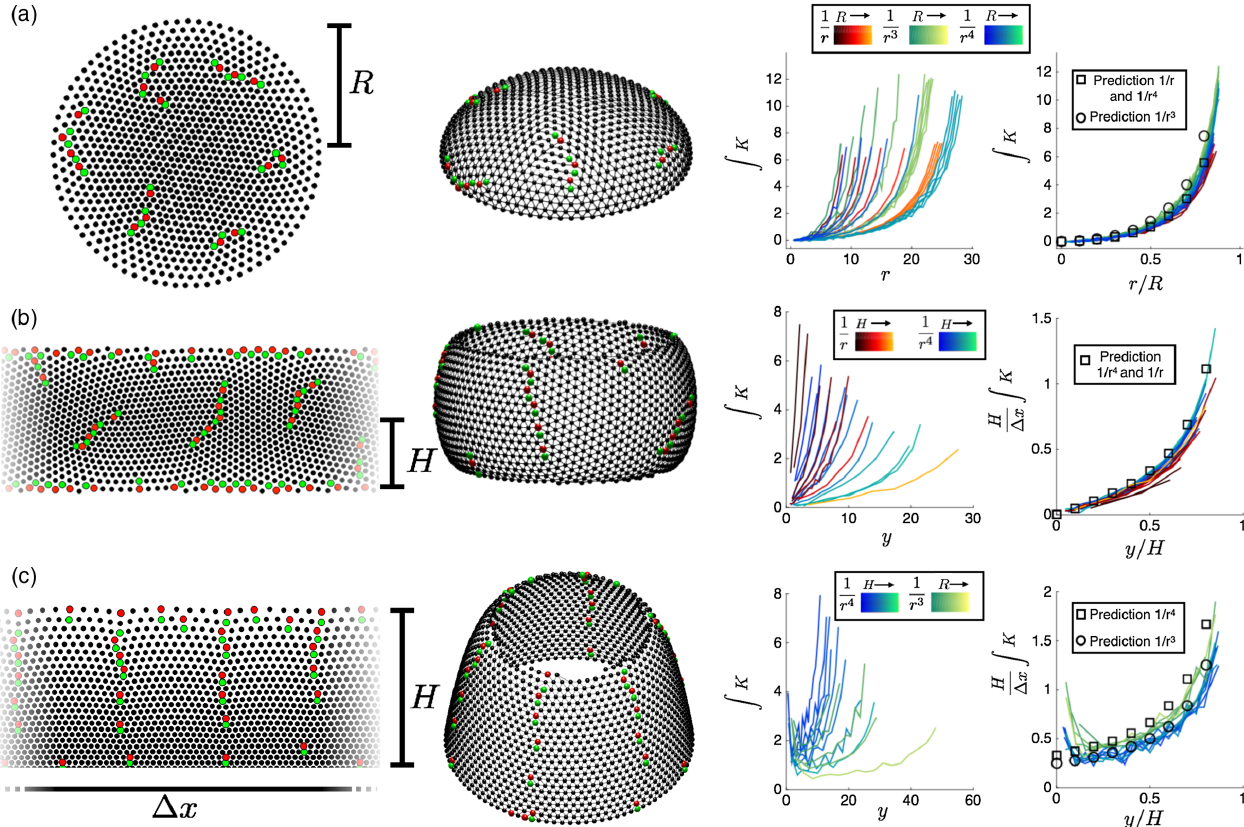
FIG. 3. Structures of simulated confined crystals. (a) Rotationally symmetric potentials. An example low-energy ∝ r 2 is shown on the left next to the configuration of Coulomb-repulsive particles confined inside the potential V ext corresponding uniform curved crystal. On the right of the crystal is a plot of the integrated curvature for particles in rotationally symmetric parabolic potentials interacting via various inverse power-law potentials and the result after scaling by the overall system size. (b) Results for translationally symmetric potentials. We show an example low-energy configuration ∝ y 2 next to the corresponding uniform curved structures. The of 1 / r 4 interacting particles inside of the potential V ext simulated system is carried out with periodic boundary conditions. Note that the entire crystal is not shown. Shown on the right is the integrated curvature profile for various inverse power-law interactions and the result after scaling by the overall system size. In this case, the integrated curvature scales linearly by the lateral system size, and thus, the integrated curvature must be ∝ y ) in the presence of a wall at the scaled by the crystal aspect ratio. (c) Result for particles in a constant force field ( V ext bottom o the crystal. Again, the simulated system is carried out with periodic boundary conditions, and the entire crystal is not